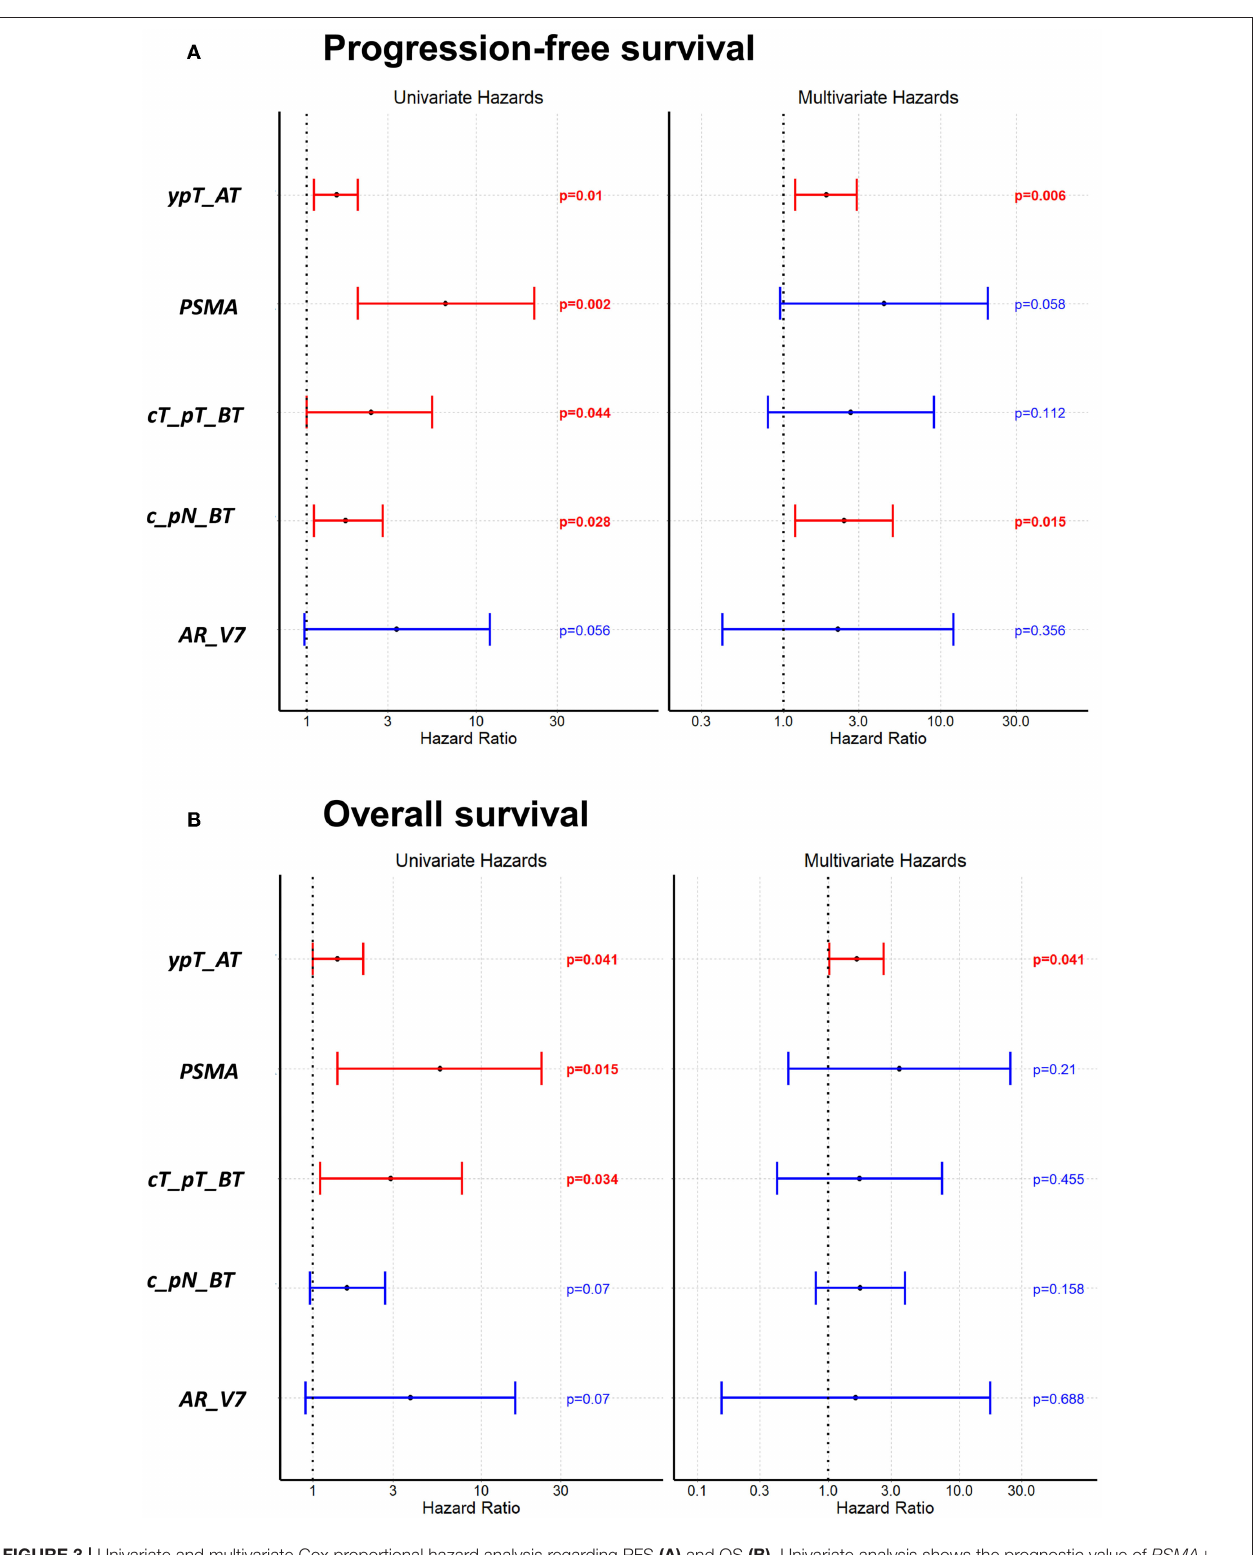
FIGURE 3 | Univariate and multivariate Cox proportional hazard analysis regarding PFS (A) and OS (B) . Univariate analysis shows the prognostic value of PSMA + CTCs for PFS and OS. ypT_AT: tumor size after therapy, cT_pT_BT: tumor size before therapy, c_pN_BT: lymph node status before therapy.